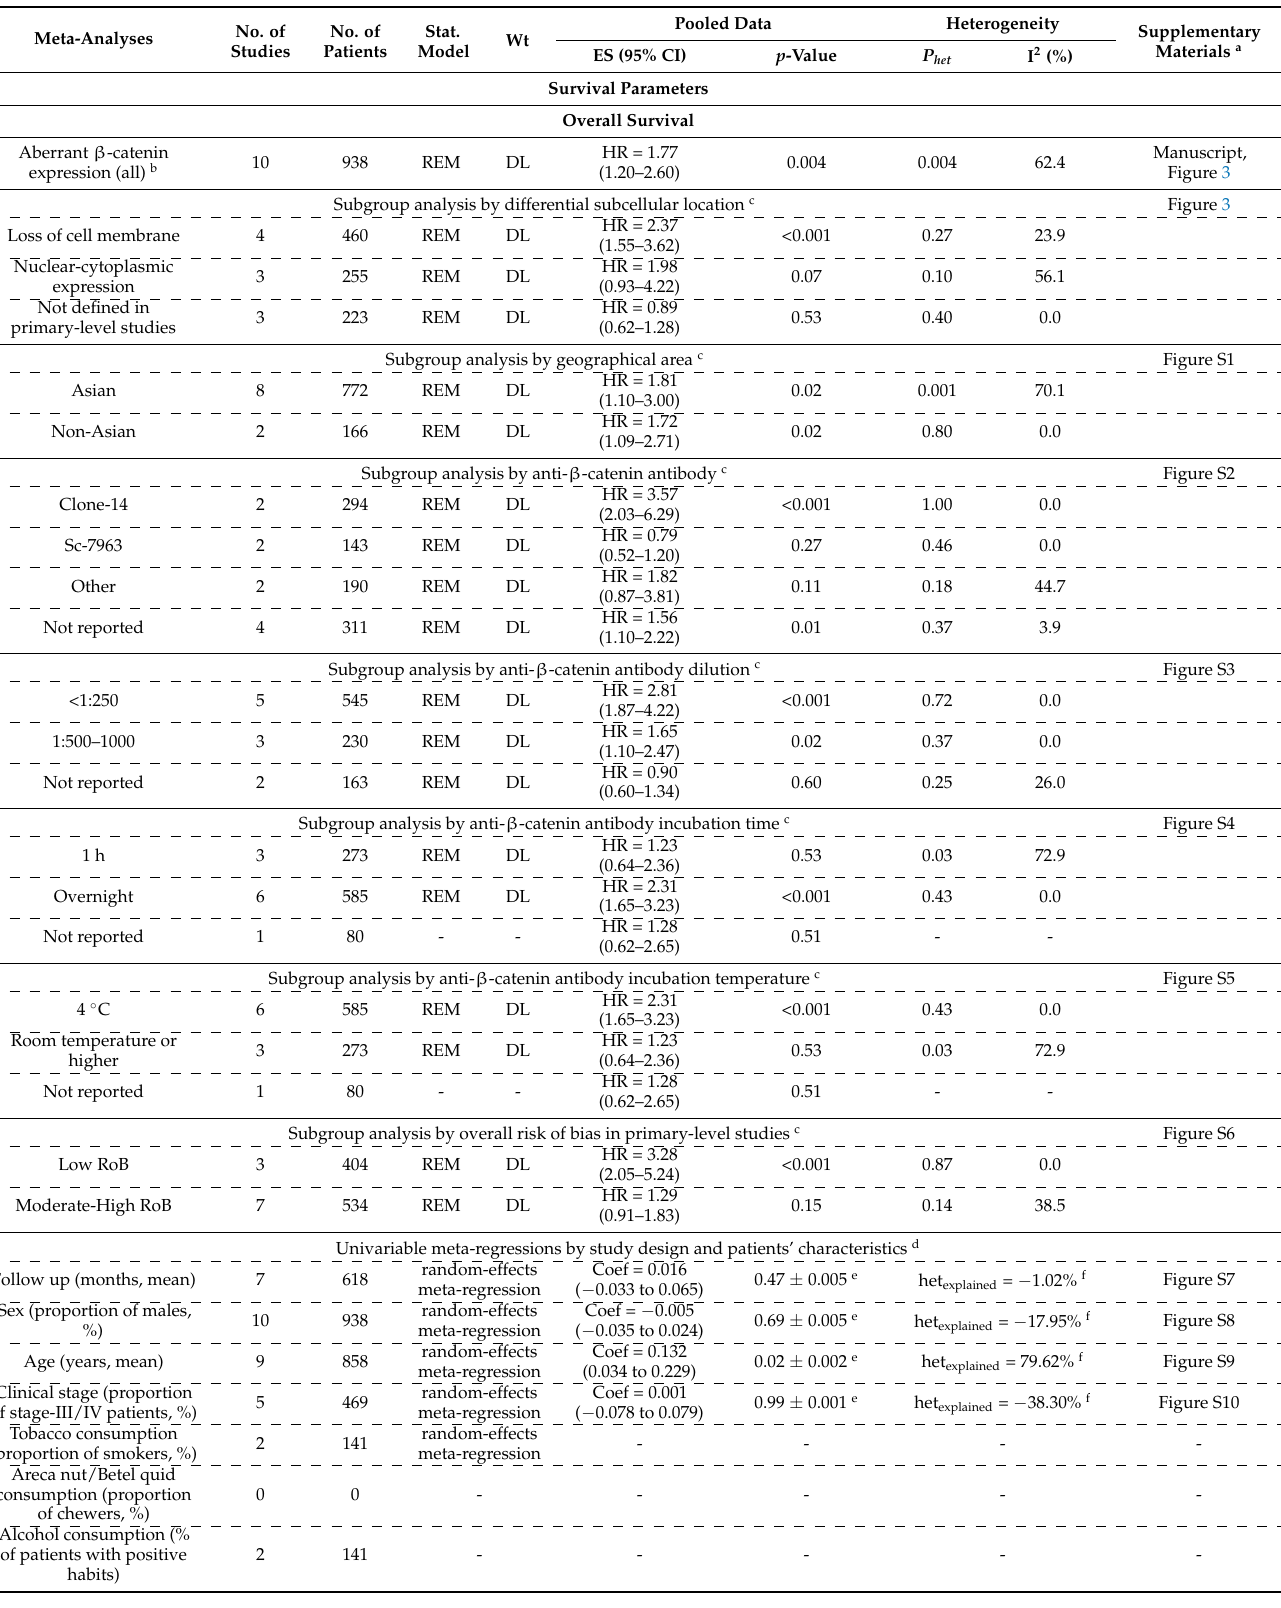
Table 2. Meta-analyses of the prognostic and clinicopathological significance of aberrant β -catenin expression in